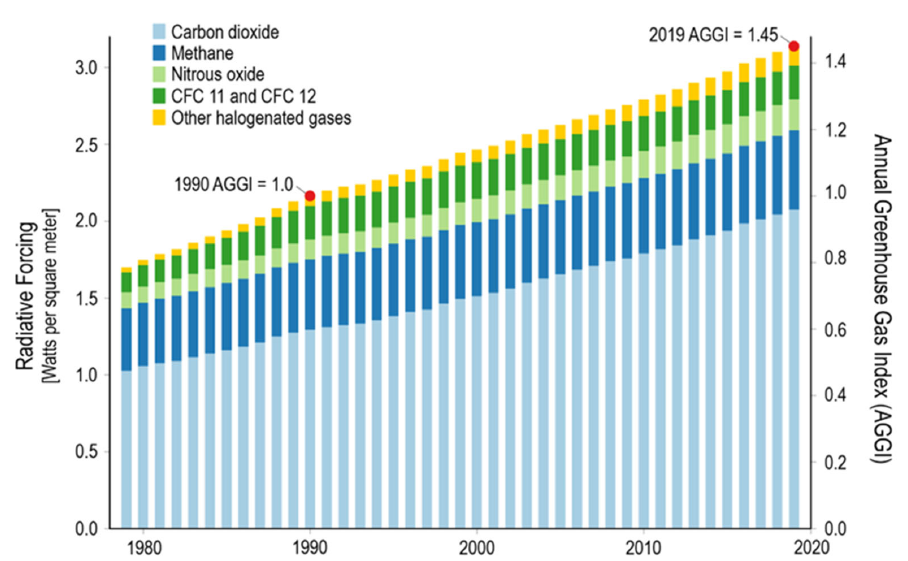
Figure 13. Increasing trend of greenhouse gas emissions from 1980 to 2020. Source: https://ccsknowledge.com/what-is-ccs/climate-change (Access date 1 December 2022).